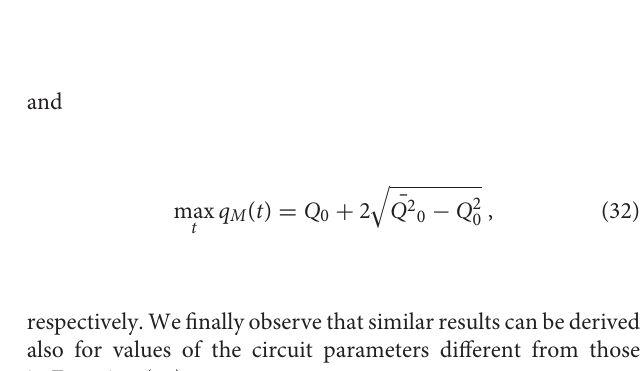
FIGURE 8 | Stable (green ⋆ ) and unstable (red (32) and minimum (31) of the PLCs (solid red) as a function of Q 0 ; maximum and minimum values of the numerically computed limit cycles (dotted dark